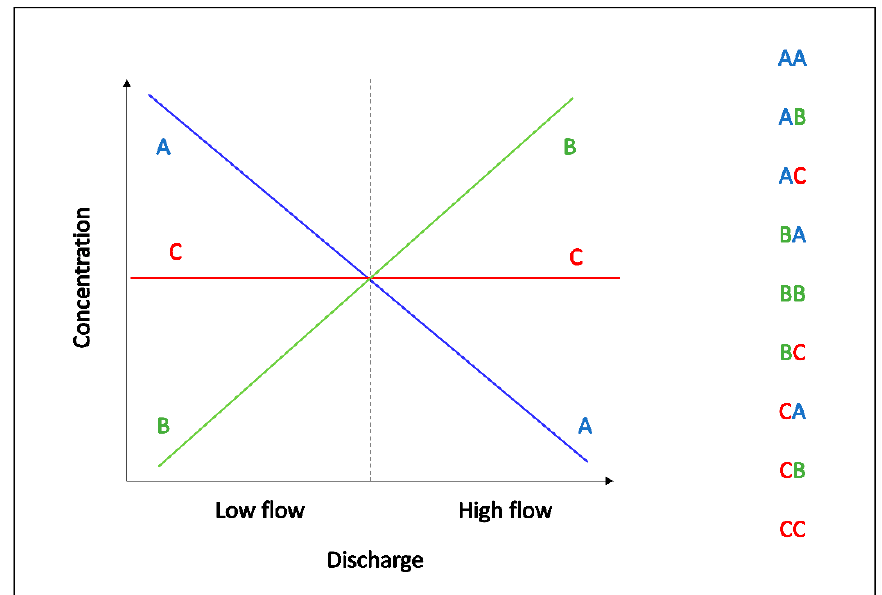
Figure 1. Nine possible archetypes for interpreting C–Q relationships with inflections in slopes (discharge thresholds) as adapted from Moatar et al., [12]. Blue, red, and green represent dilution, chemostatic, and enrichment, respectively.